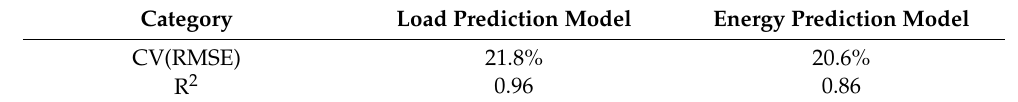
Table 5. Verification of the ANN model.